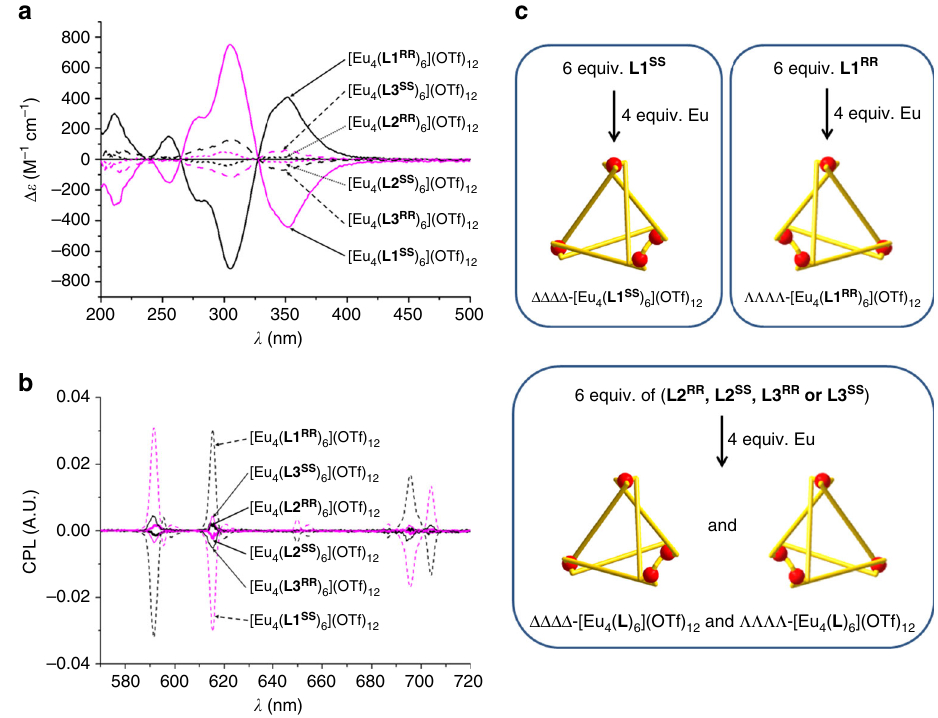
Fig. 2 The chiral optical measurements. a Circular dichroism spectra of [Eu 4 ( L1 ) 6 ](OTf) 12 , [Eu 4 ( L2 ) 6 ](OTf) 12 , [Eu 4 ( L3 ) 6 ](OTf) 12 in MeCN. The order of Cotton effect is [Eu 4 ( L1 ) 6 ](OTf) 12 > [Eu 4 ( L3 ) 6 ](OTf) 12 > [Eu 4 ( L2 ) 6 ](OTf) 12 . b Circular polarized emission spectra of [Eu 4 ( L1 ) 6 ](OTf) 12 (1.07 × 10 − 6 M), [Eu 4 ( L2 ) 6 ](OTf) 12 (1.16 × 10 − 6 M), [Eu 4 ( L3 ) 6 ](OTf) 12 (1.11 × 10 − 6 M) in MeCN. The order of CPL intensity is [Eu 4 ( L1 ) 6 ](OTf) 12 > [Eu 4 ( L3 ) 6 ](OTf) 12 > [Eu 4 ( L2 ) 6 ](OTf) 12 . c Schematic representation of a plausible reason to explain the different extent of chiral optical intensity. L1 leads to very stereoselective formation of either ΛΛΛΛ - or ΔΔΔΔ -isomer, whereas L2 or L3 form a mixture of ΛΛΛΛ - and ΔΔΔΔ -isomers with different